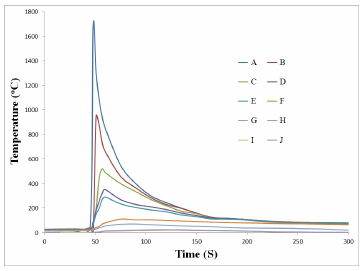
Figure 6. Temperature distribution on line 3 from 0 to 300s.